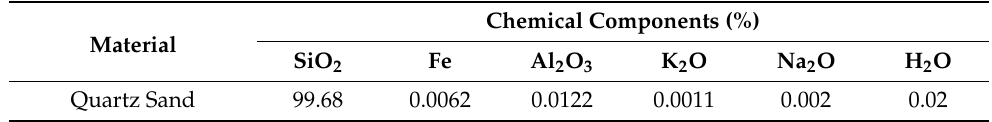
Figure 1. The chemical components of cement and silica fume: ( a ) P.O 42.5 MPa cement, ( b ) SF93 silica fume. Table 2. The composition of quartz sand.